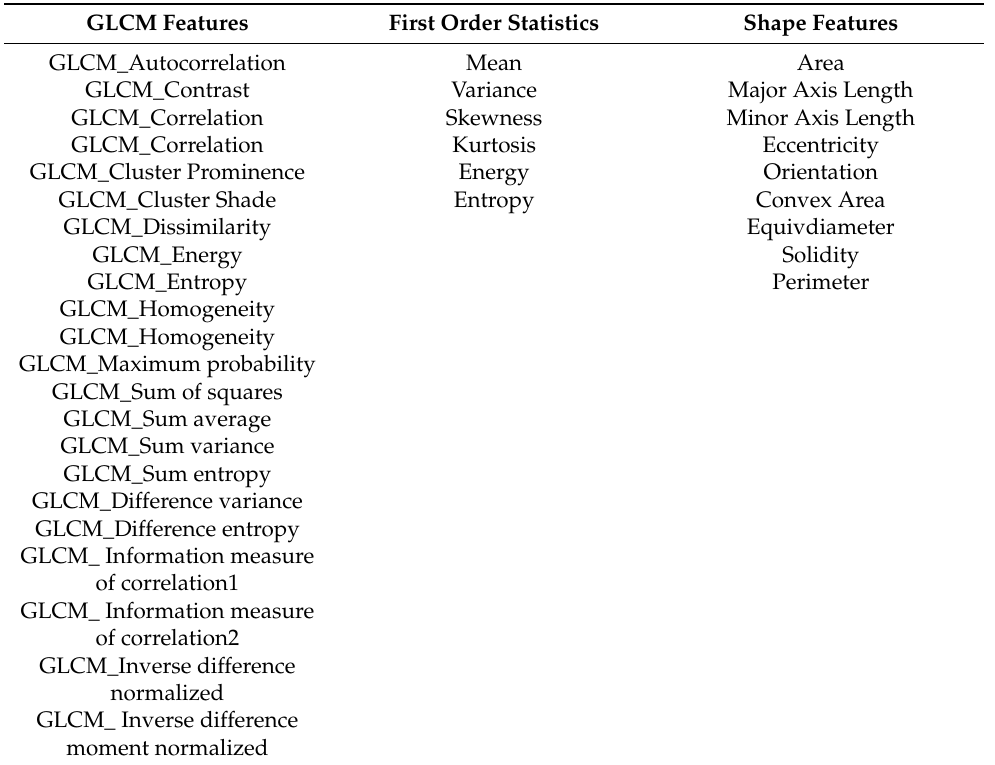
Table 2. Features extracted using grey-level co-occurrence matrix (GLCM), first order statistics, and shape features.